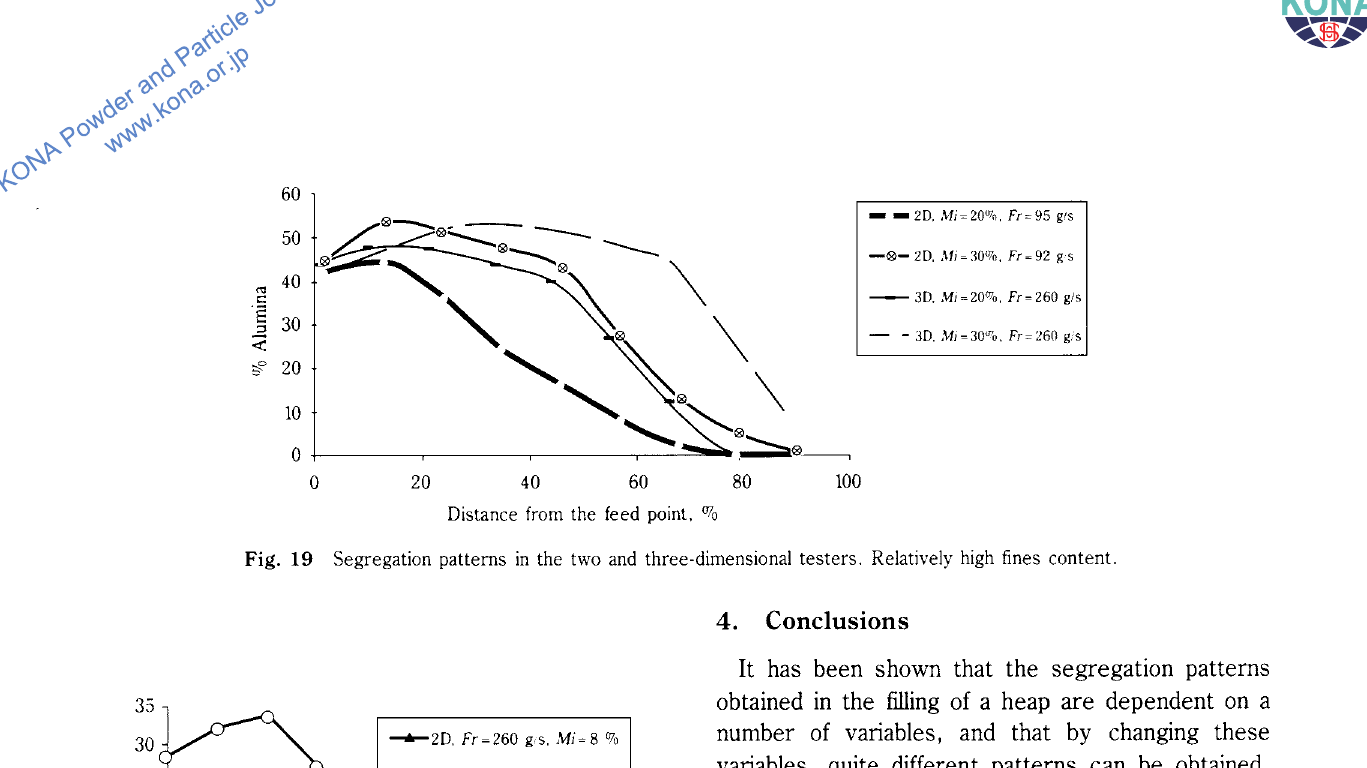
Distance from the feed point. %